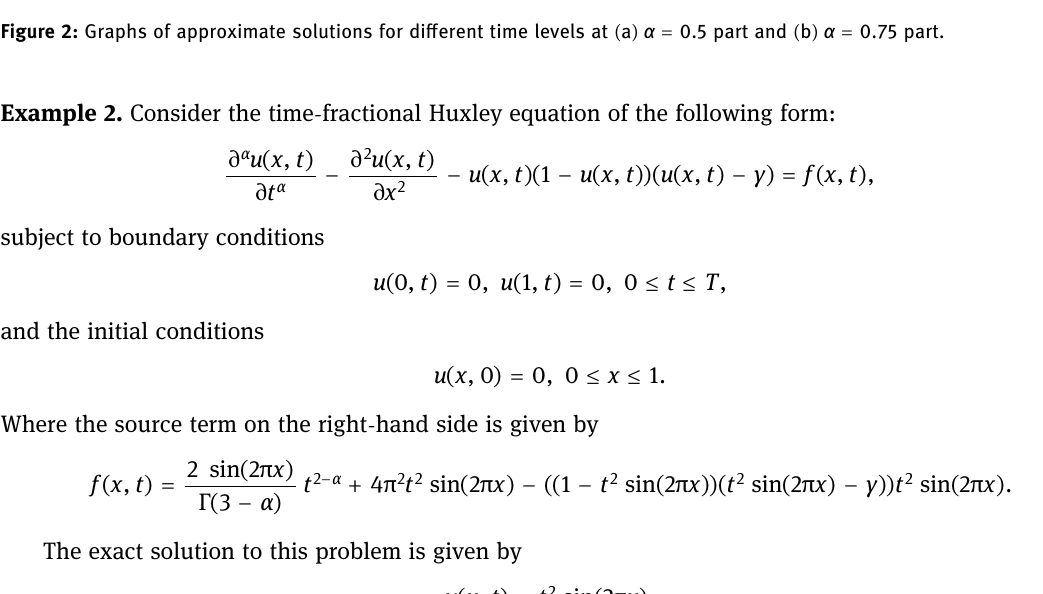
comparison between the maximum absolute error and l 2 error norm at di ff erent values of γ and di ff erent